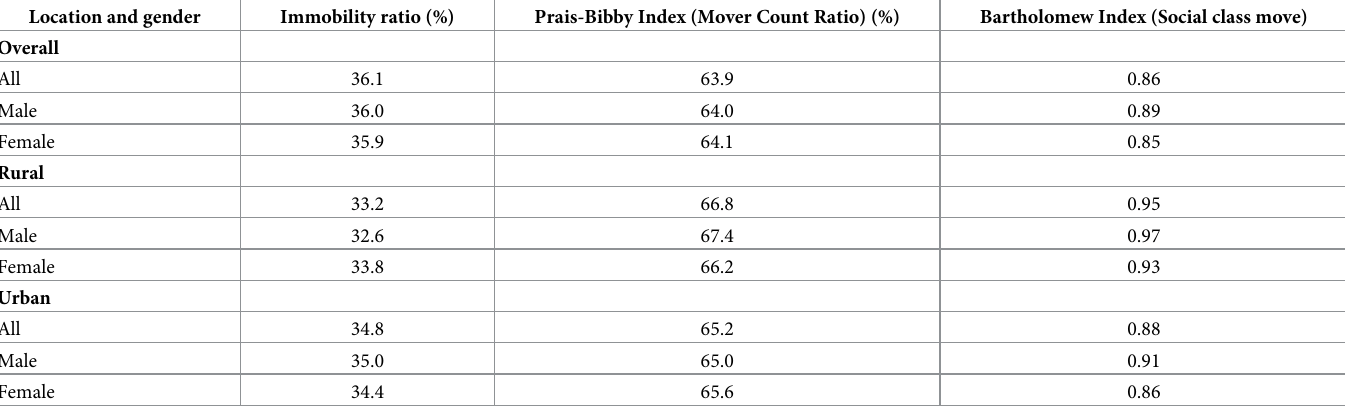
Table 5. Estimates of Prais-Bibby and Bartholomew indices of